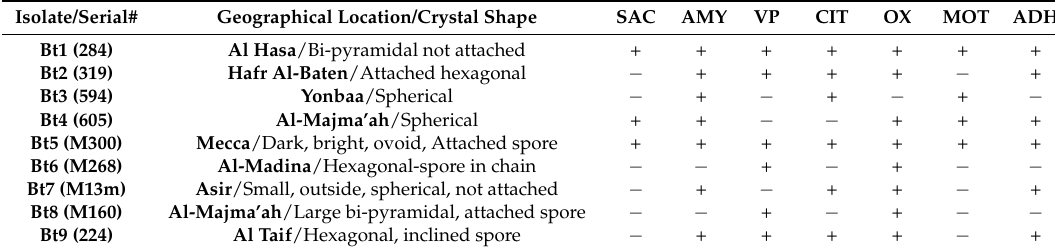
Table 1. Biochemical typing of Bt isolates.